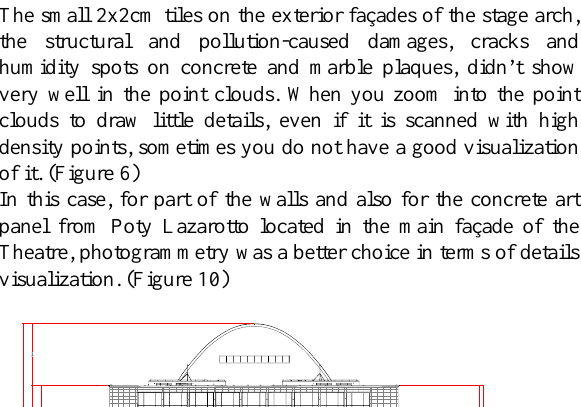
The small 2x2cm tiles on the exterior façades of the stage arch,